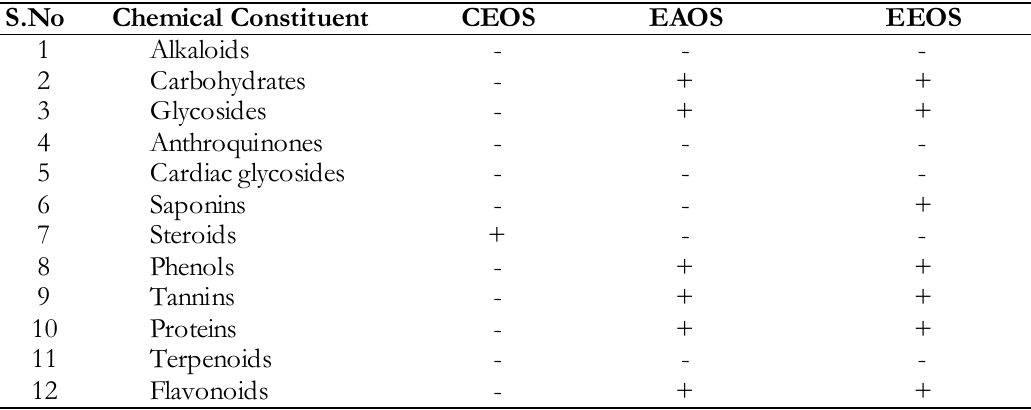
Table I. Qualitative phytochemical analysis of O. spinosa roots S.No